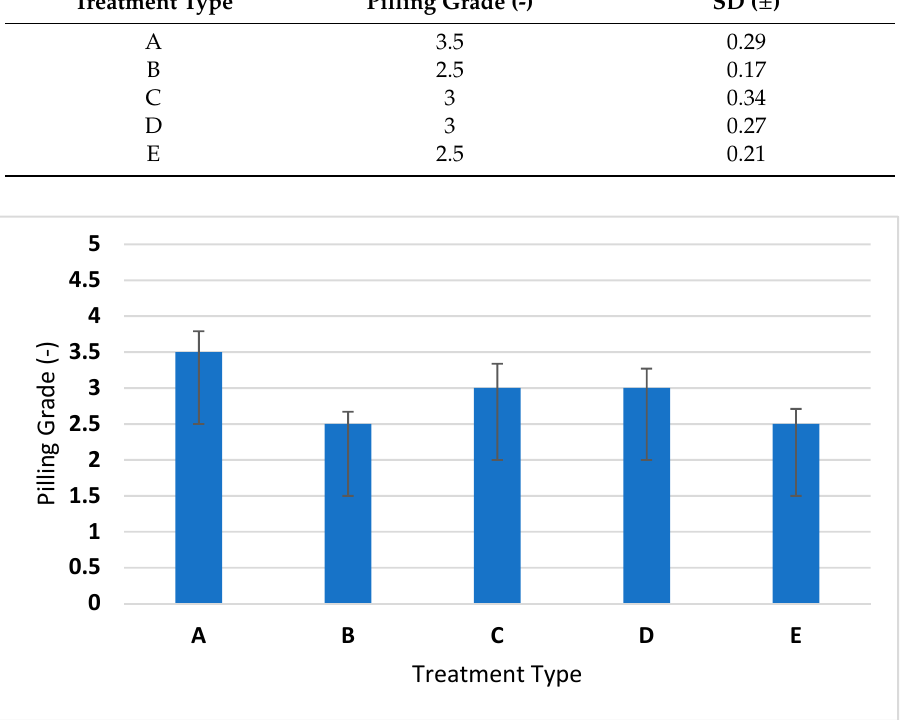
Figure 2. Pilling grades for different treatments (A) grey fabric, (B) simple wash, (C) normal finish, (D) silicon finish, and (E) wicking finish) .